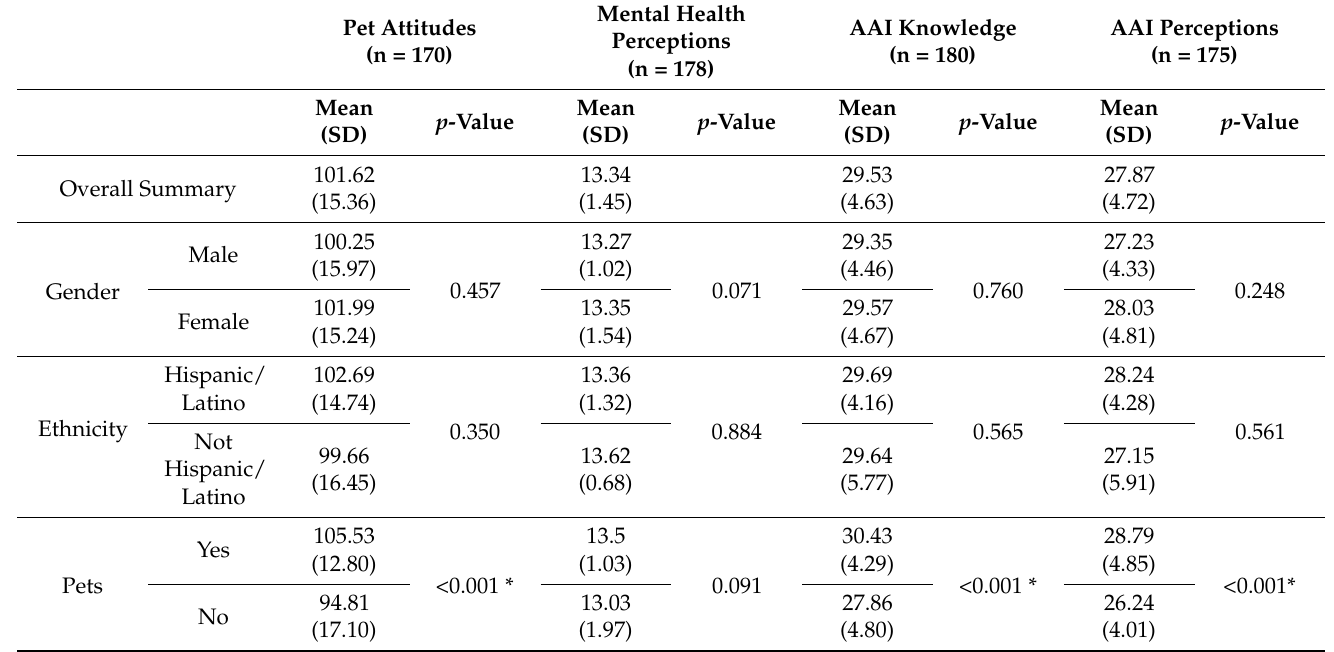
Table 2. Mean scores for pet attitudes, mental health perceptions, AAI knowledge, and AAI perceptions—overall, by gender, ethnicity, and pet